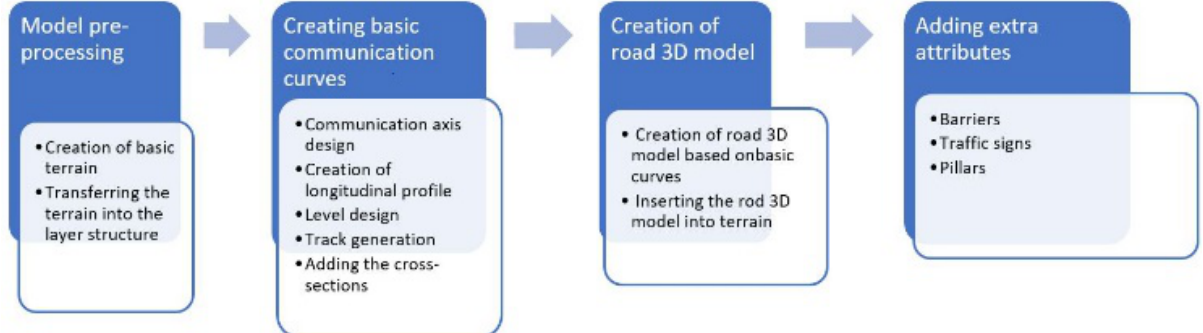
Figure 11. Road infrastructure creation process.